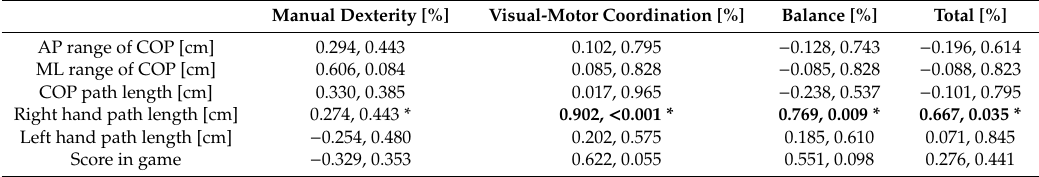
Table 3. Spearman’s correlations (r,p) between scores of the MABC, its subcategories and COP-related parameters, hand paths, and game score in the research group (N =